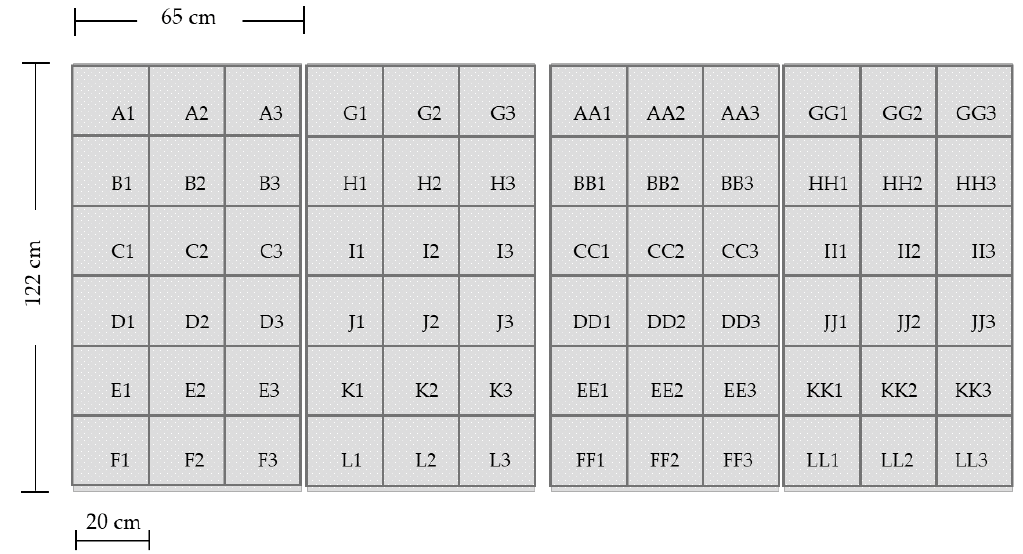
Figure 2. Polypropylene sheets with grid lines and labeling numbers.